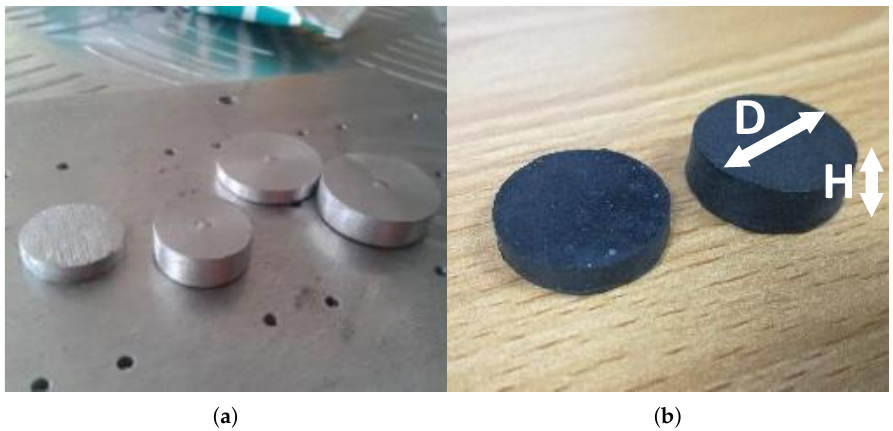
Figure 12. Fabrication of the sensor pills: ( a ) spacers to alter the thickness values of the pills; ( b ) conductive polymer pills after the